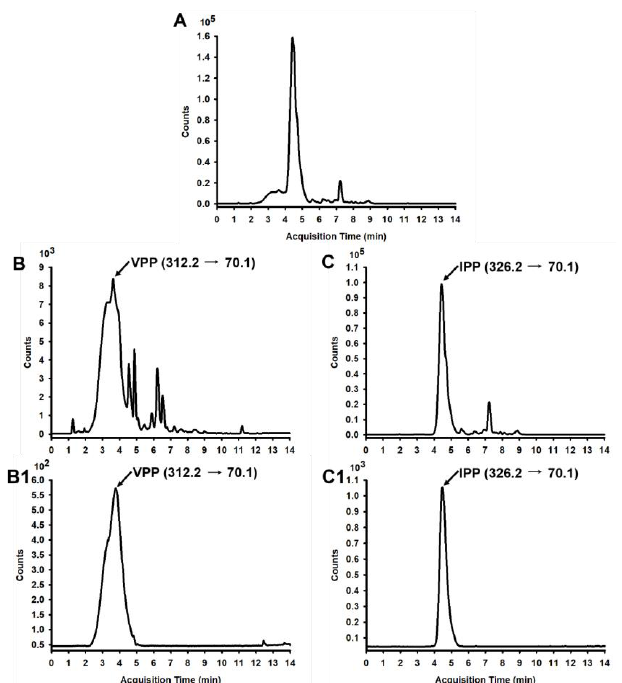
Figure 1. LC-MS/MS chromatogram of VPP and IPP in CH. ( A ) TIC of CH; ( B ) Chromatogram of VPP in CH in positive MRM mode, and the retention time (RT) of VPP is 3.500 min; ( B1 ) Standard chromatogram (SC) of VPP in positive MRM mode; ( C ) Chromatogram of IPP in CH in positive MRM mode, and the RT of IPP is 4.968 min; ( C1 ) SC of IPP in positive MRM mode.